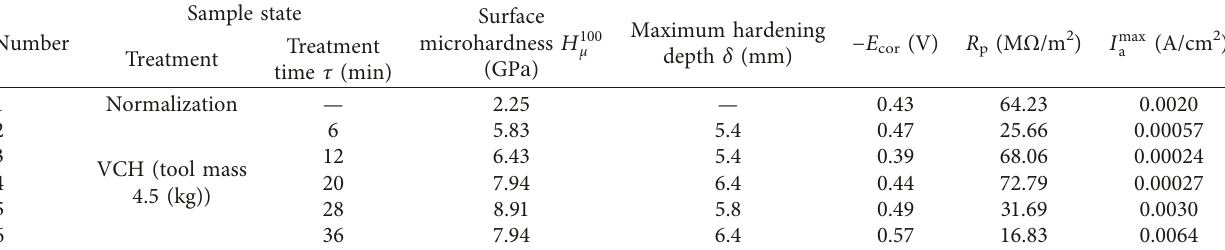
Table 1: Mechanical and electrochemical characteristics of 40 Kh steel after VCH.